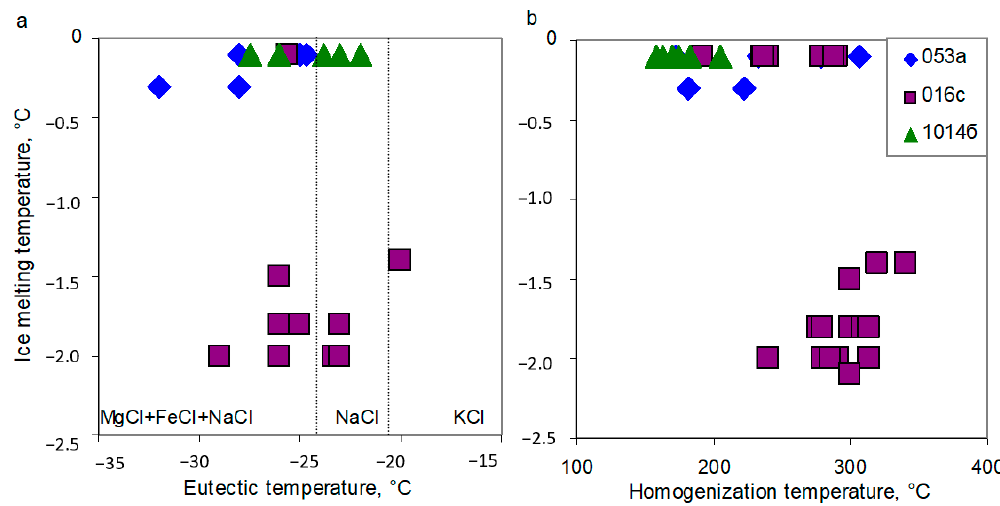
Figure 7. Plots of the last ice crystal melting temperature vs. eutectic temperature ( a ) and last ice crystal melting temperature vs. homogenization temperature ( b ), illustrating the distribution patterns of the data points for different types of quartz.